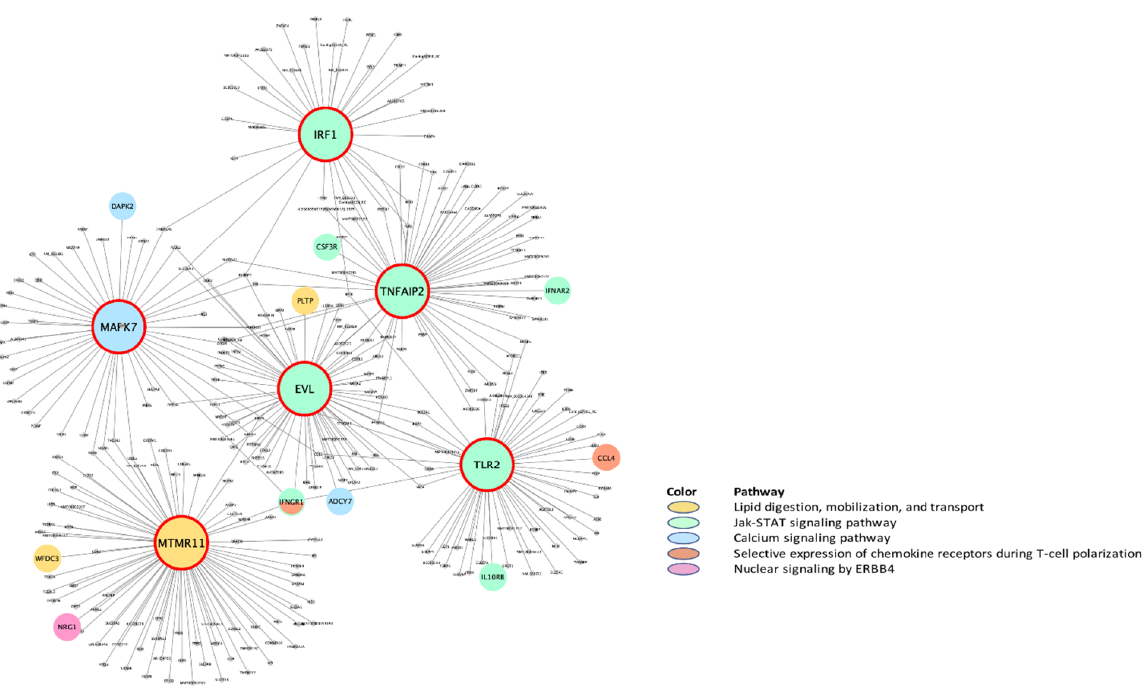
Figure 4. Liver-specific gene-regulatory networks of top KDs in meta-analysis of CRP and IL6. (CRP, C-reactive protein; eQTL, expression quantitative trait loci; IL6, interleukin-6; KD, key drivers. The bigger nodes with red outlines are the top KDs in the enriched pathway obtained from weighted KD analysis. The subnetworks of the KDs are indicated by different colors according to differences in their canonical functions.).